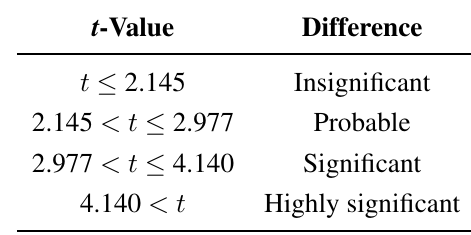
Table 3. Critical boundaries according to Student’s t-distribution for a two-tailed